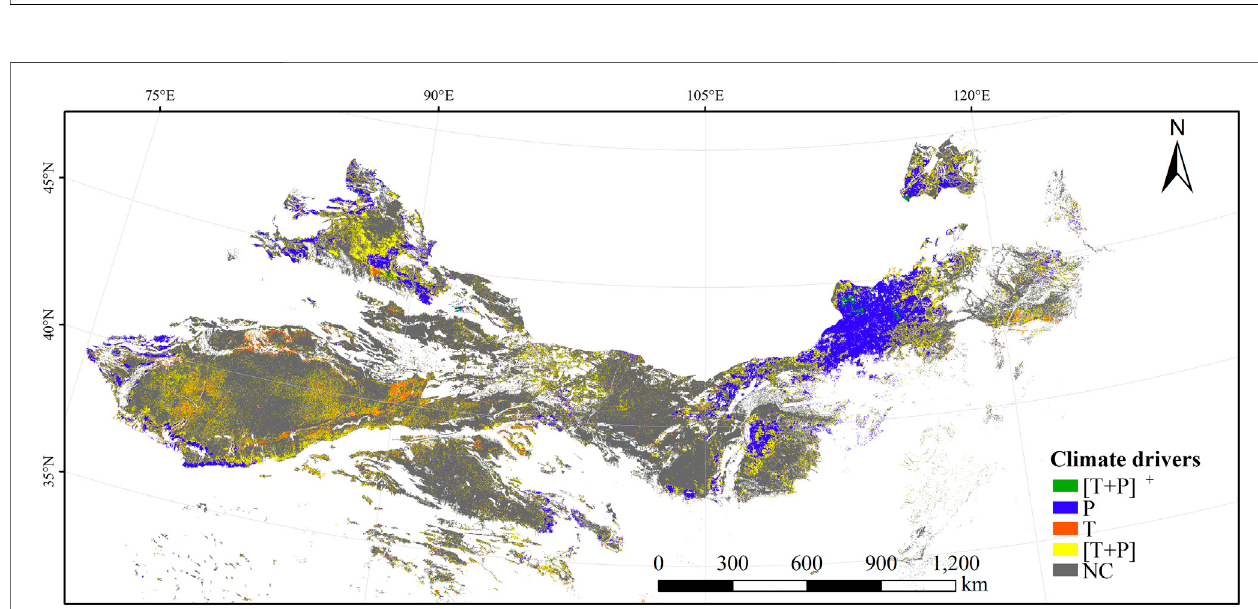
FIGURE10 | Spatial distribution ofthe effects ofthedriving factors onchangesin themulti-year normalized-difference vegetation index (NDVI) in the desert areaof China from 1998 to 2015. [T + P] + represents changes driven strongly by temperature and precipitation, P represents changes driven mainly by precipitation, T represents changes driven mainly by temperature, [T + P] represents changes driven weakly by temperature and precipitation, and NC represents changes driven by non-climate factors.